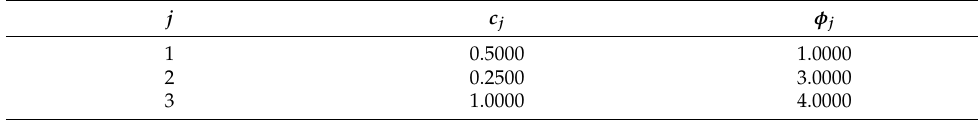
Table 2. Parameters of the function f ( x ) in